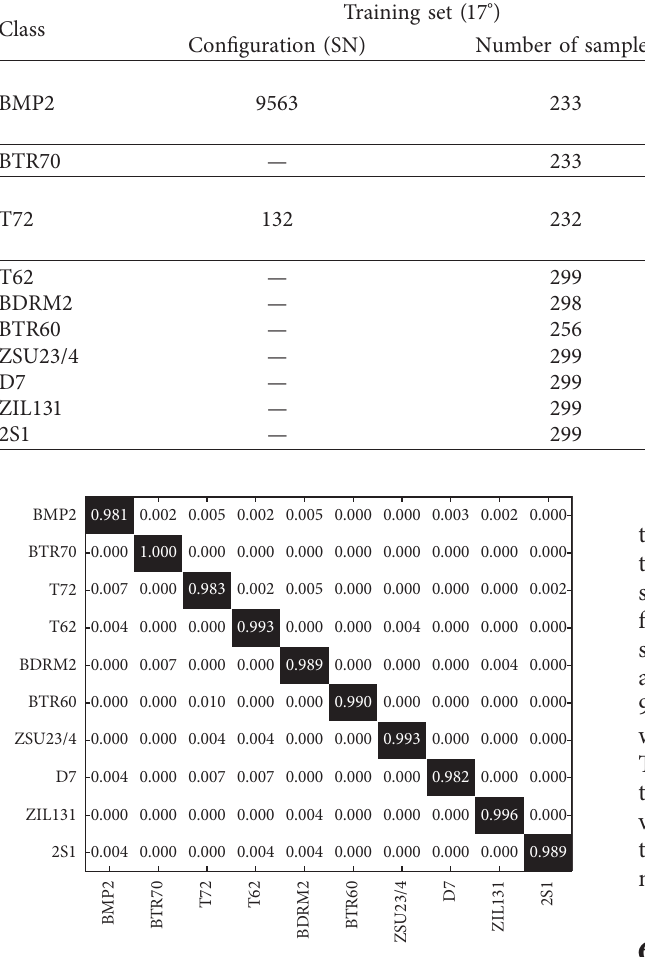
Figure 4: The confusion matrix of the proposed method on 10 classes of targets under SOC. Table 2: Performance of methods under